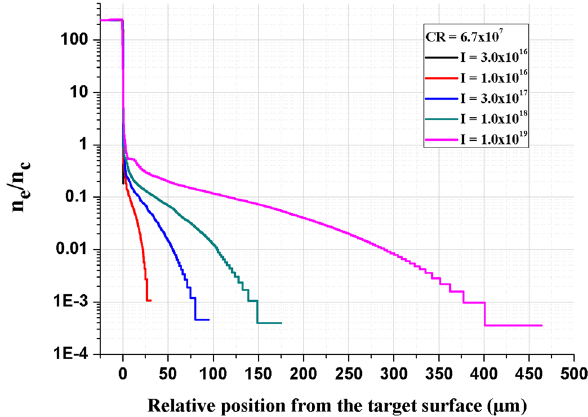
Figure 8. Normalized electron density n e /n c as a function of the position from the target surface for CR = 6.7 × 10 7 and for the five laser intensities